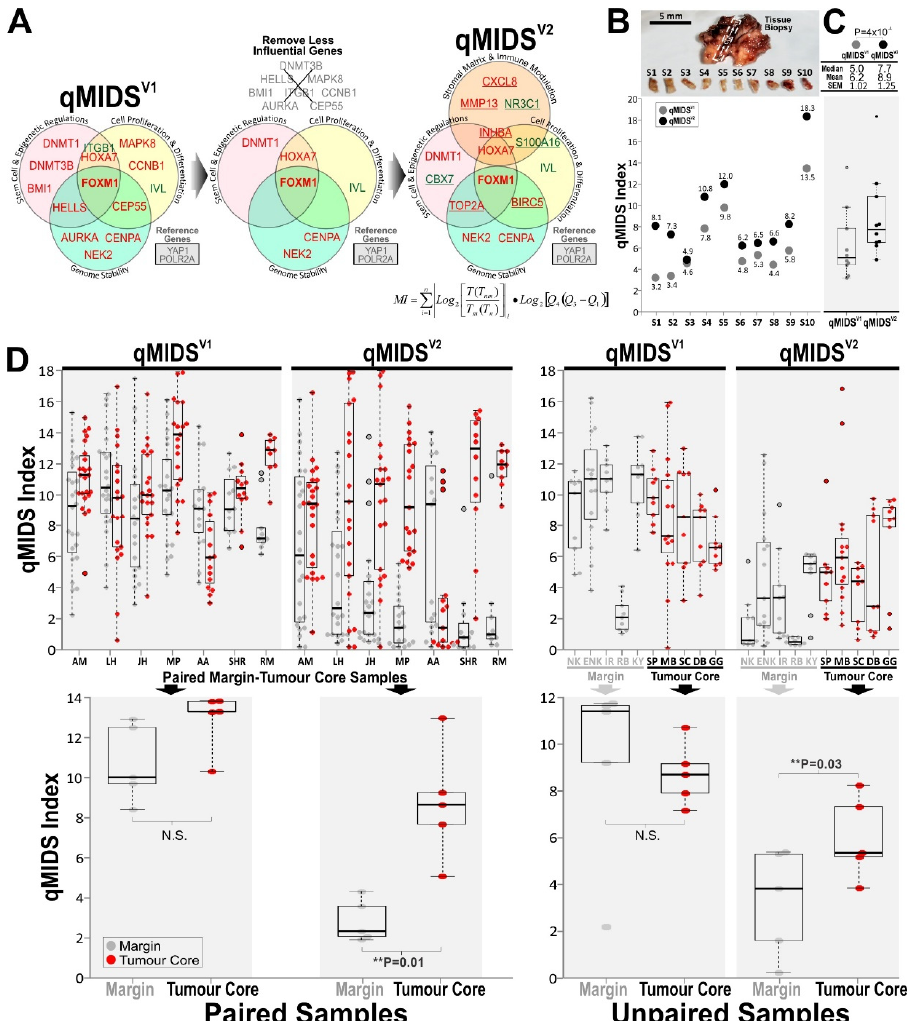
Figure 2. Comparisons between qMIDS V1 and qMIDS V2 . ( A ) Biomarker gene panel and their respective functional groups in qMIDS V1 compared to qMIDS V2 . Diagrams indicate the removal of less influential genes from qMIDS V1 and replacement of new genes with functional regulation of stroma matrix and immune modulation in qMIDS V2 . The qMIDS algorithm [24] was used to compute 16 gene expression levels into a qMIDS malignancy index (MI) for each sample. ( B ), Case study using a single OSCC tumour core tissue biopsy for qMIDS V1 and qMIDS V2 comparison. Photograph showing the cut site of a strip of tissue across the tumour sample which was subsequently dissected into 10 pieces of 1 mm 3 tissue fragments. Each fragment was subjected to qMIDS V1 and qMIDS V2 assays simultaneously and their corresponding qMIDS indexes were shown adjacent to the data points. Of note, some fragments (e.g., S1, S2 and S10) showed much larger differences between qMIDS V1 and qMIDS V2 which may reflect the molecular heterogeneity across the tumour tissue. ( C ), Data from ( B ) were plotted as box-whisker dot plots (box horizontal lines represent median and 25–75% percentiles, whiskers represent lowest and highest values, outliers are beyond the whiskers), t -test were performed. p -values were indicated in the panel above. ( D ), Similar to methods in ( B , C ), each sample was cut into 9–24 fragments for qMIDS V1 and qMIDS V2 comparison whereby paired and unpaired margin and tumour core samples were analysed. A total of n = 498 sub-fragments (from paired samples of 7 patients) and n = 204 sub-fragments (unpaired samples of 10 patients) were independently analysed. Top panels show box-whisker dot plots of individual fragments for each patient ( x -axis showed individual patients’ sample IDs). Panels below show box-whisker dot plots of average values of all fragments from each sample and corresponding statistical t -test p